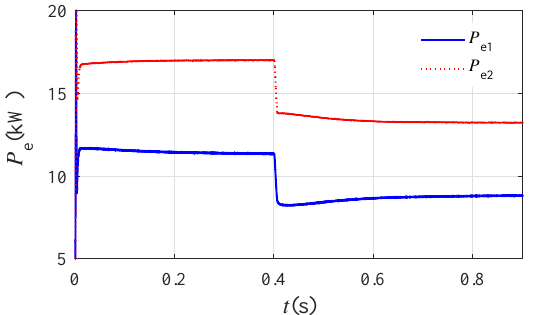
Figure 13. Active power distribution of parallel systems.